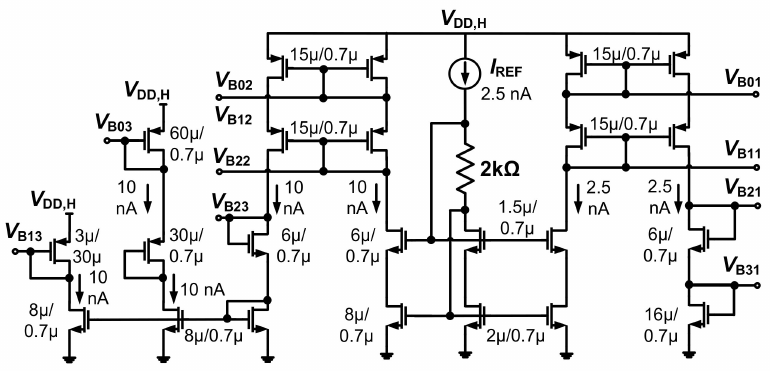
Figure 9. Schematic of the bias